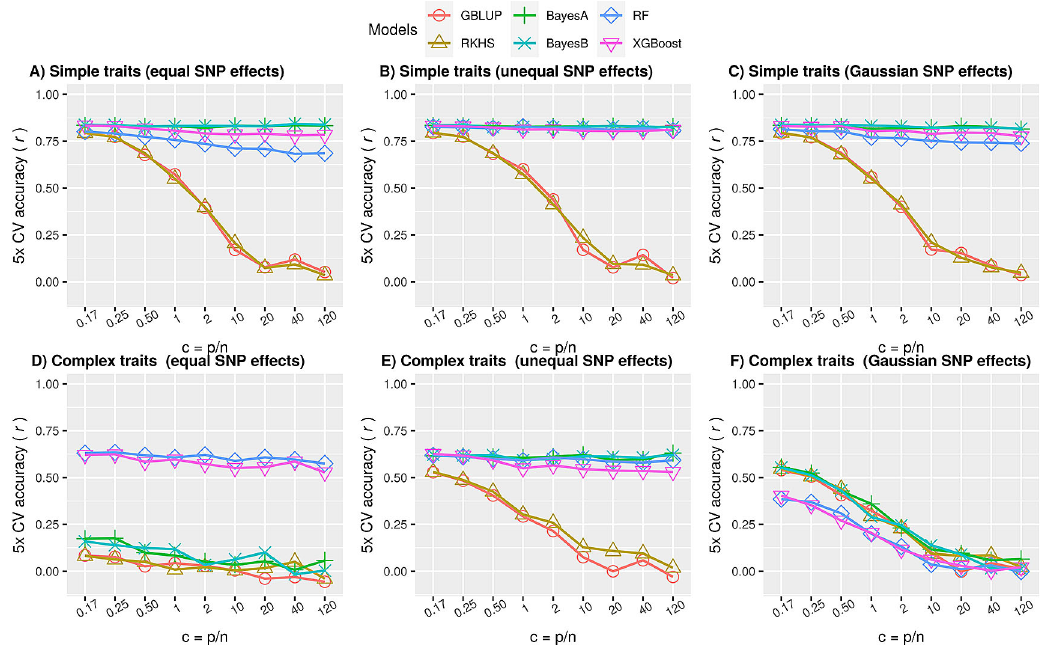
Figure 2. Comparison of prediction performances using simulated simple and complex phenotypes. Perfor- mance of parametric (GBLUP), semi-parametric regression (RKHS), parametric Bayesian (BayesA, BayesB) and nonparametric ML (RF and XGBoost) methods as average accuracy over 5 -fold cross-validation of test data. Here accuracy is defined as Pearson correlation coefficient between true and predicted values. Each panel is a subset of thesimulatedscenariosin ‘ simdata ’ foraparticular heritabilityand#QTNs.Theratioofthenumberofmarkerstothe number of samples ( c = p / n ) increases from left to right in each subplot. A) Simple traits, simulated as polygenic phenotypes with only additive effects such that #QTNs is equal to 5 and h 2 is 0.7, using equation (1), with all QTNs having equal effects. The largest standard error of mean for all values of c for each of the model was 0.023, 0.018, 0.007, 0.008, 0.018 and 0.009 for GBLUP, RKHS, BayesA, BayesB, RF and XGBoost respectively; B) similar to A, except one of the QTN had a large effect than others. The largest standard error of mean for all values of c for each of the model was 0.022, 0.022, 0.006, 0.007, 0.006 and 0.008 for GBLUP, RKHS, BayesA, BayesB, RF and XGBoost respec- tively; C) similar to A and B, except QTN effects were sampled from a Gaussian distribution; D) Complex traits, simulated as polygenic phenotypes with both additive and epistatic effects such that #QTNs equal to p /2 and h 2 is equal to 0.4, using equation (2), suchthat all QTNs had equal additiveeffects. Two of the QTNs were attributed tothe epistatic effect such that Broad-sense heritability was set to 0.8 ( H 2 = h 2 + h 2 e = 0.8). The largest standard error of mean for all values of c for each of the models was 0.03; E) similar to D, except one of the QTN had a large effect than others; F) similar to D and E, except QTN effects were sampled from a Gaussian distribution (see ML methods outperform parametric methods for complex traits